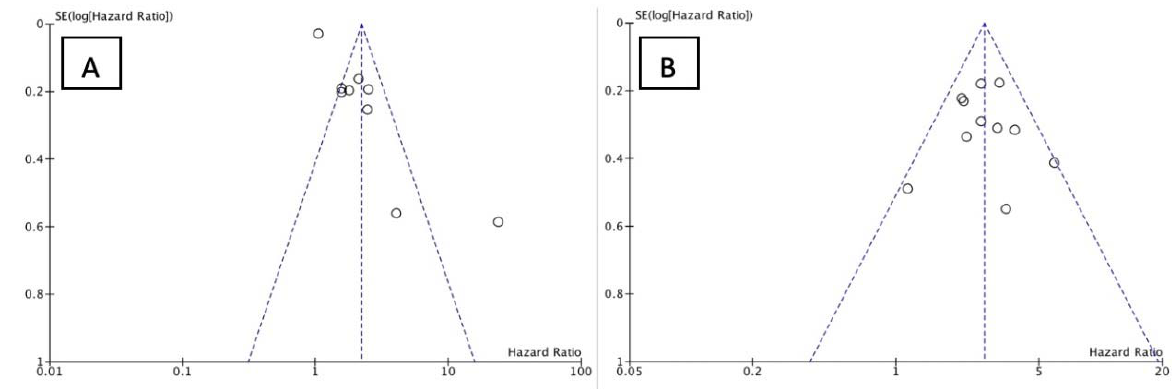
Figure 4. Funnel plot of NLR ( A ) PFS and ( B ) OS. The small circle represent individual study.